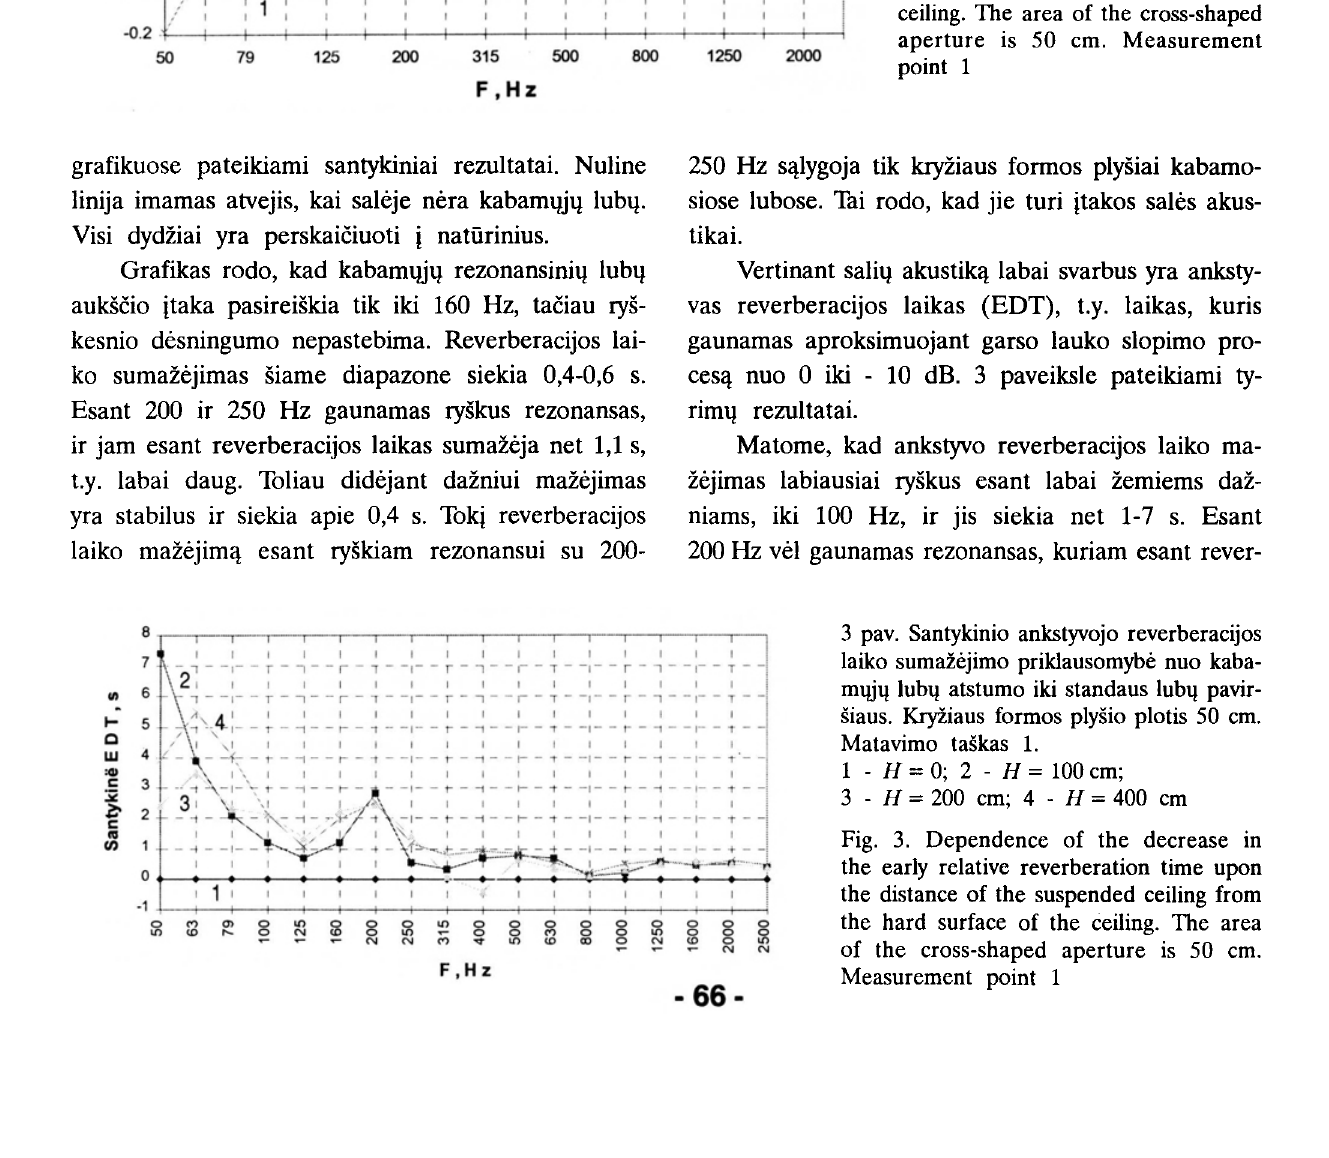
250 Hz sqlygoja tik kryziaus formos plysiai kabamo